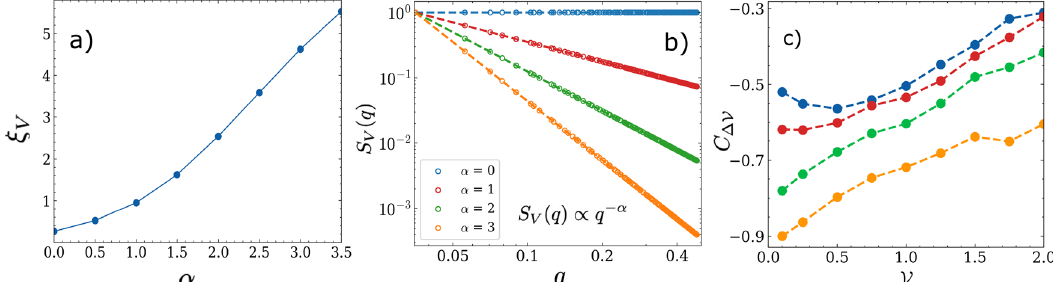
Fig. 2 Correlation properties of random potential. a The dependence of the correlation length ξ V for the random potential model in Eq. (16) on the correlation degree α . b the Fourier transform S V ( q ) of the spatial correlation function of the random potential, given for selected values of α . c the integral degree of correlations between the disorder potential V i and the order parameter Δ i , de fi ned in Eq. (2), as function of the disorder strength V , given for several values of the potential correlation degree α